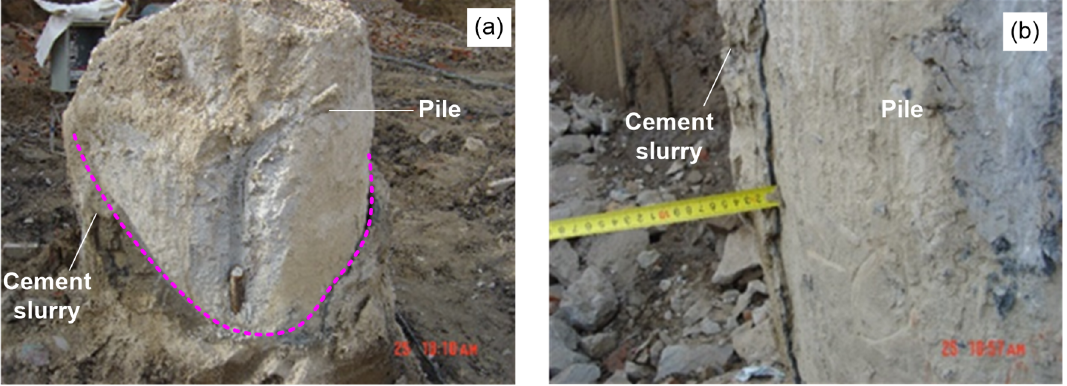
Figure 5. Photos of the bored pile after excavation: ( a ) solidified cement slurry and ( b ) thickness measurement.